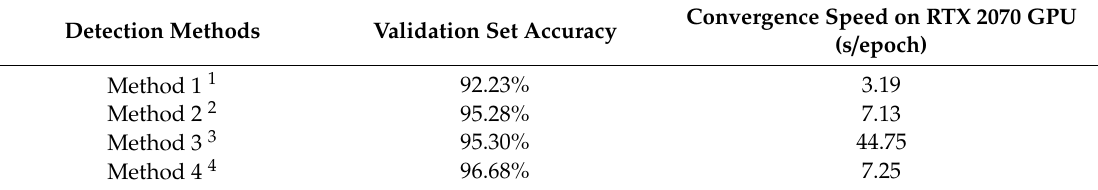
Table 5. Comparison of several detection